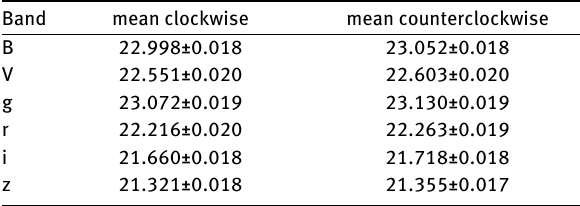
Table 4. Mean, standard error of the mean, and the one-tail P value of the differences between the magnitude of clockwise galaxies and counterclockwise galaxies in COSMOS such that the 5% highest values and the 5% lowest values were removed.